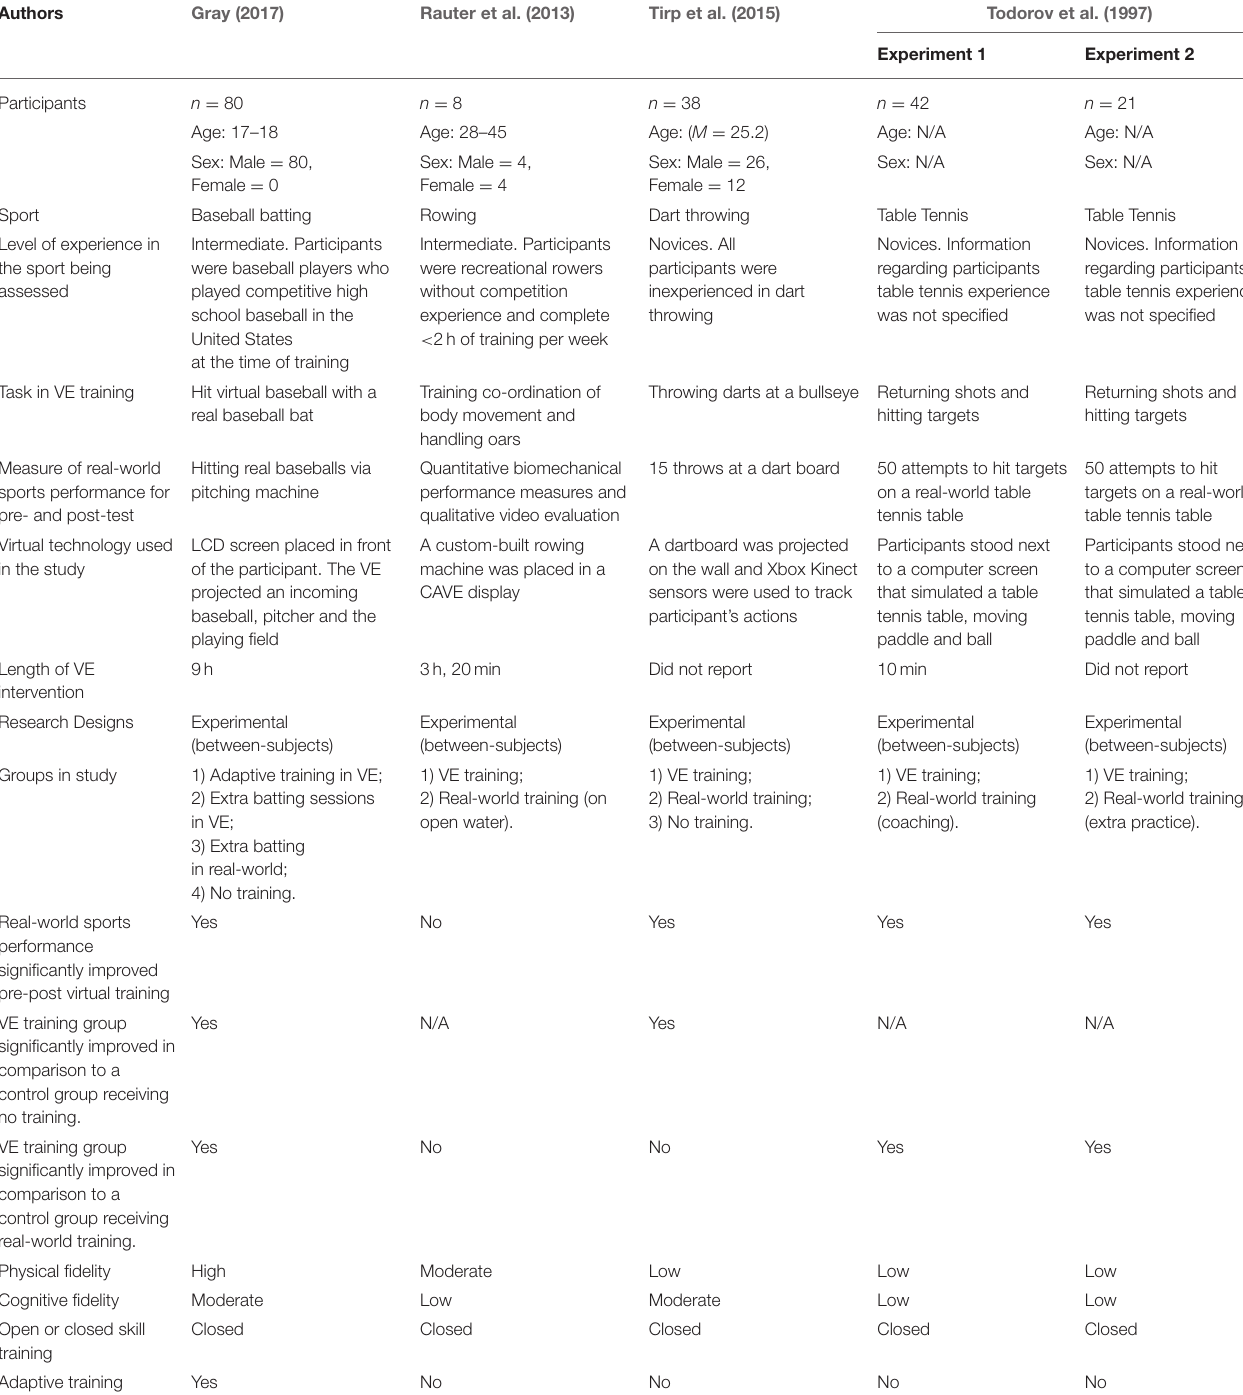
TABLE 1 | Summary of included articles.